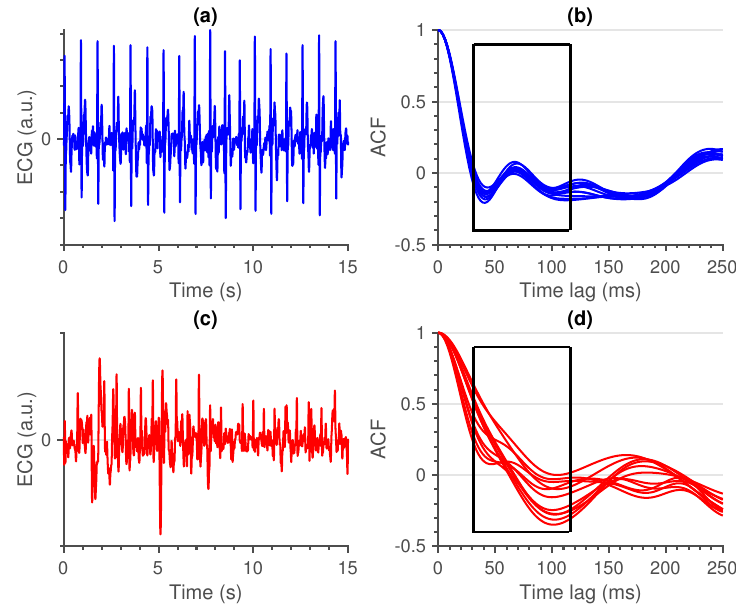
Figure 3. Comparison between a clean (blue) and noisy (red) ECG signal ( a , c ), together with the ACF’s of their respective sliding windows ( b , d ). The difference between the ACF’s within the search window, as depicted by the black box, is clearly higher for the noisy ECG